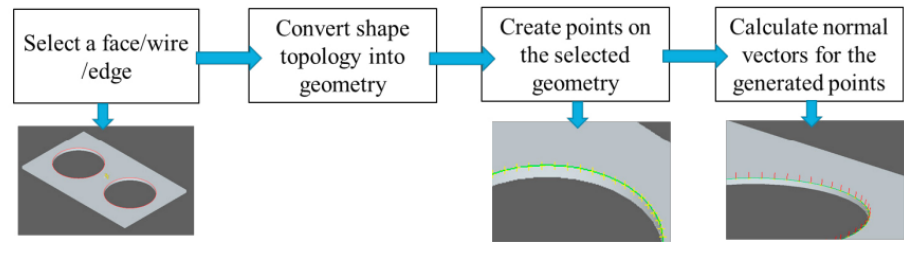
Figure 1. Steps to generate points (source: adapted from